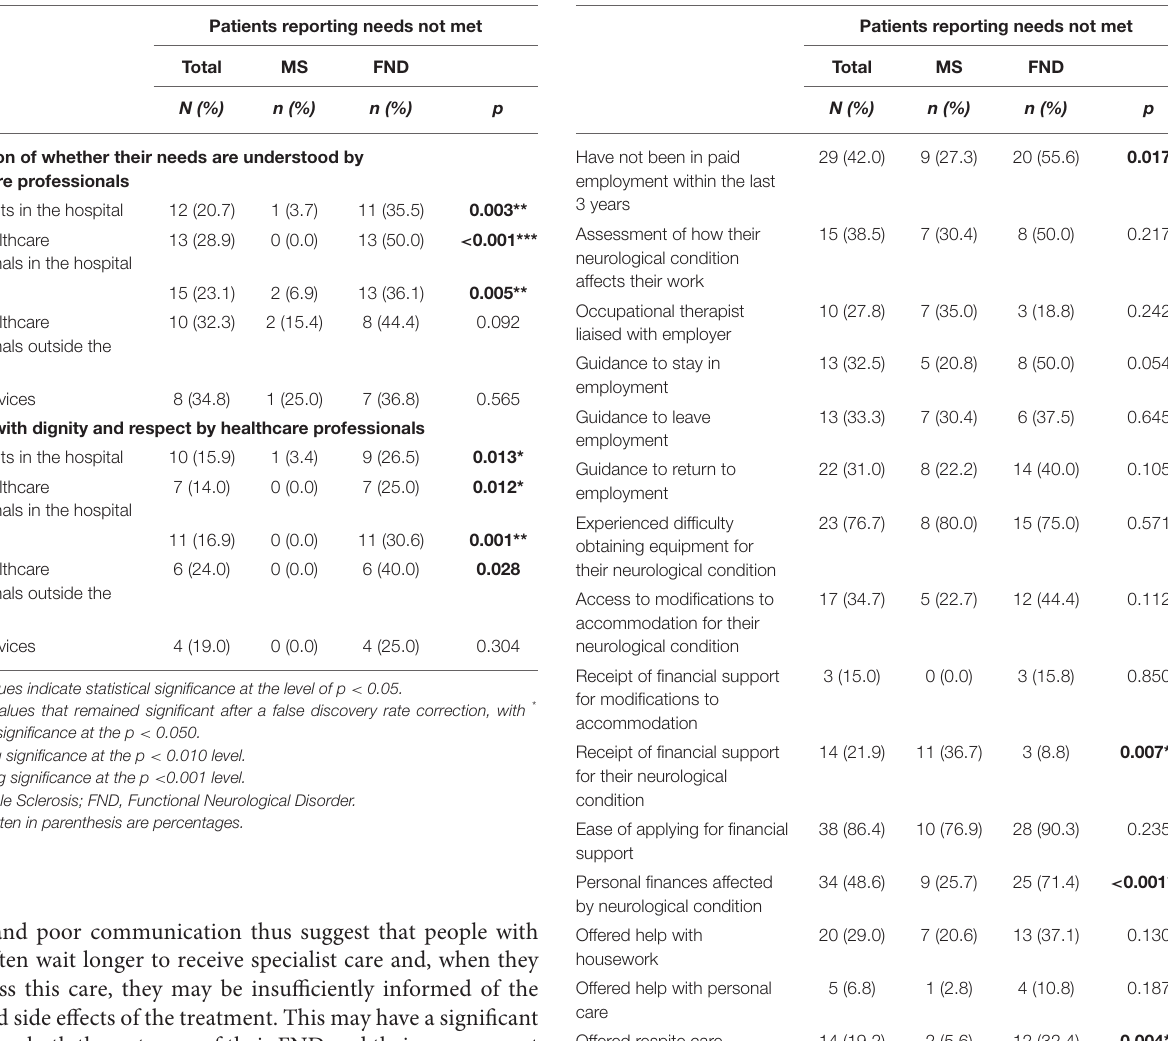
TABLE 3 | Patients reporting a problem regarding their relationships with health and social care professionals.